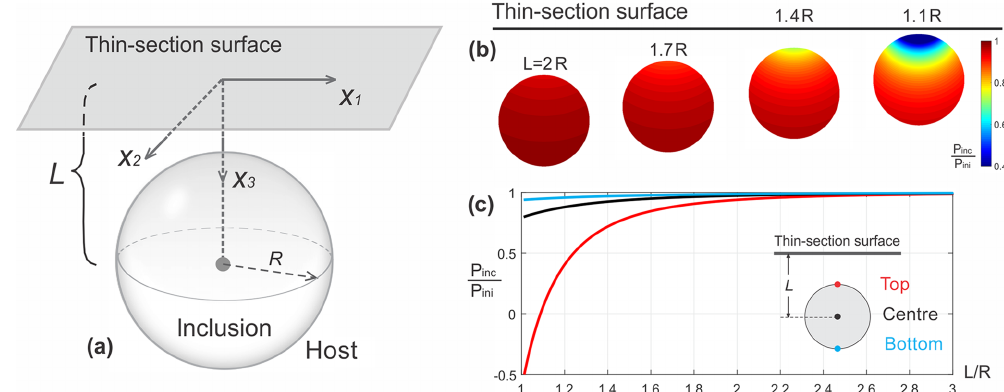
Figure 7. (a) Analytical model configuration of a mineral inclusion close to the thin-section surface. The distance between the surface to the inclusion centre is denoted by L . (b) Pressure distribution on an x – z plane. The pressure is scaled by the initial inclusion pressure ( P ini ). The initial inclusion pressure is under force equilibrium in an infinite host. The analytical model describes the amount of pressure release when the inclusion approaches the thin-section surface. (c) Pressure at three localities (inclusion top, centre, and bottom) as a function of dimensionless depth L/R . The analytical solution of Eq. (22) is used for the pressure